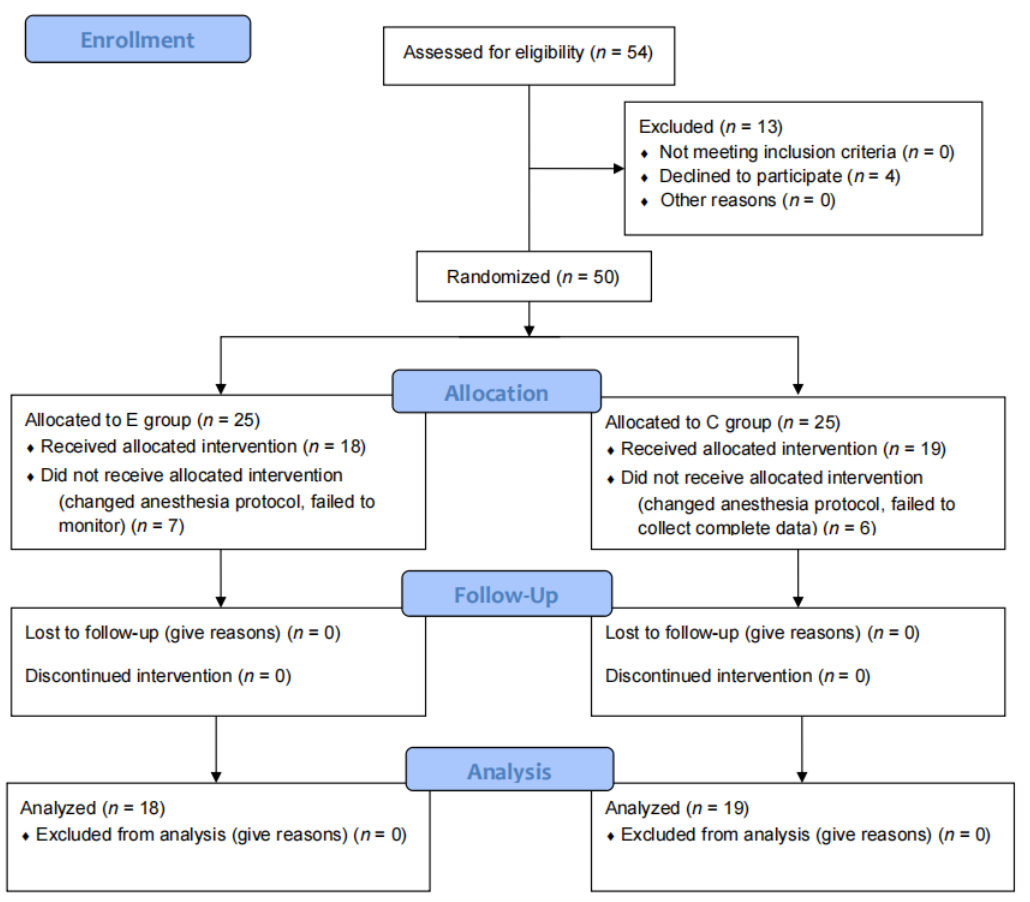
Figure 1. CONSORT flowchart of recruitment and inclusion of subjects.